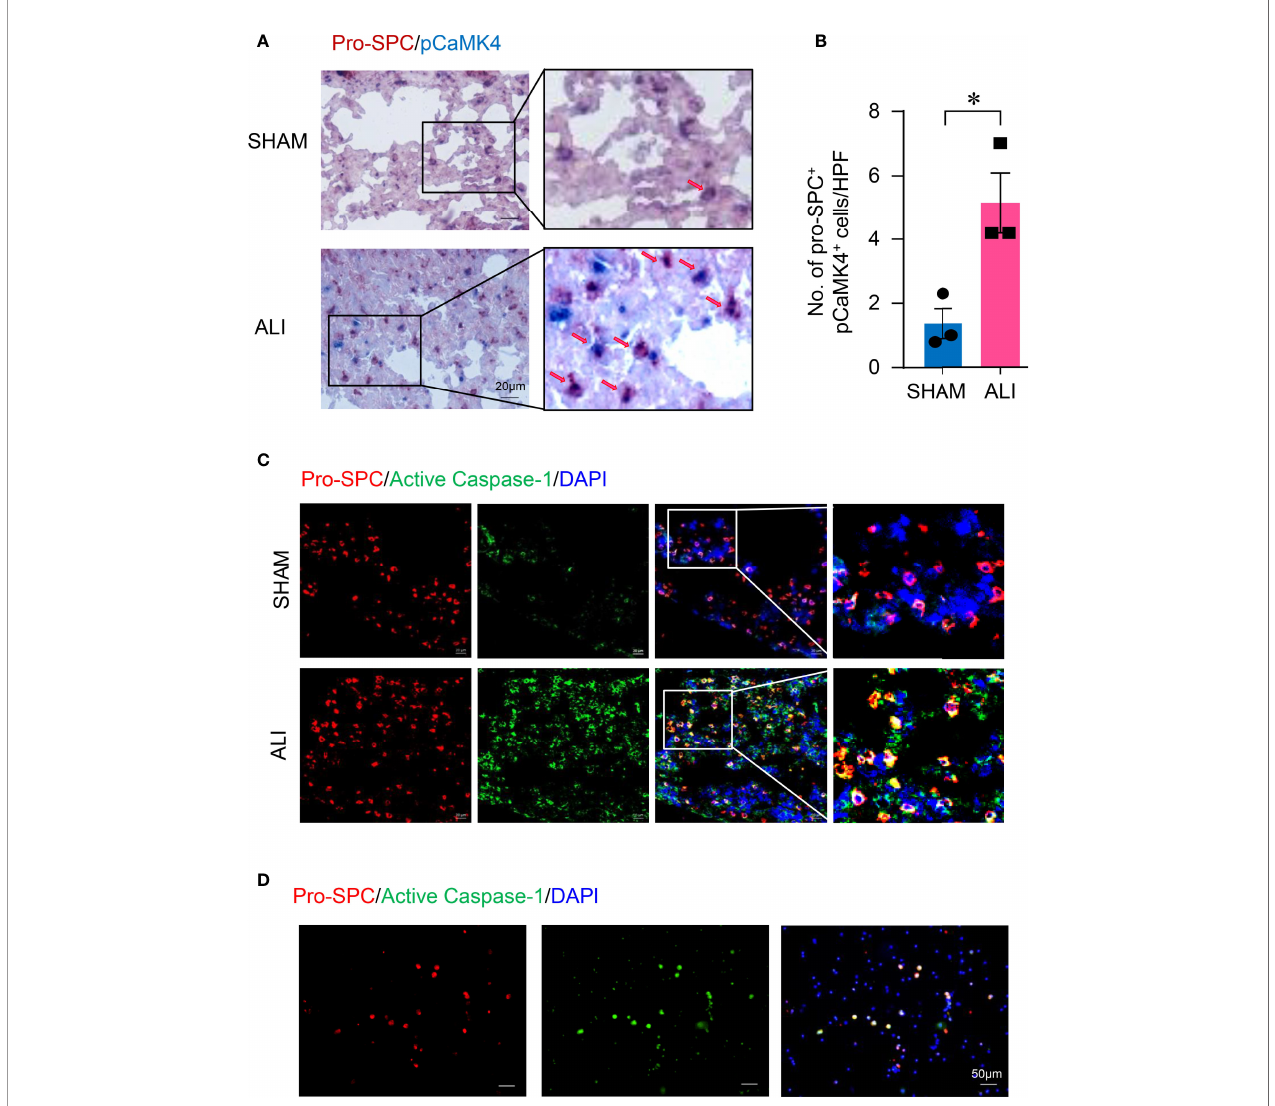
FIGURE 3 | Activation of CaMK4 and NLRP3 in fl ammasome in type II lung alveolar epithelial cells in ALI. (A, B) Lungs were collected from ALI or normal control mice and sectioned. pro-SPC (red) and pCaMK4 (blue) expression in the lung were identi fi ed by immunohistochemistry. Representative images were shown and numbers of pro-SPC + pCaMK4 + cells (arrows) in the lung tissues per high power fi eld (HPF) were summarized from 3 samples. Scale bar: 20 m m. (C) Slices from lungs of ALI or control mice were stained with Alexa Fluor A555-conjugated anti-pro-SPC (red) and FAM-FLICA (green). Representative images were shown. Scale bar: 20 m m. (D) Bronchoalveolar lavage fl uid (BALF) was collected from patients with ARDS and cells were isolated by centrifugation. Cells were stained with Alexa Fluor A555-conjugated pro-SPC (red) and FAM-FLICA (green). Representative images were shown. Scale bar: 50 m m. All data are mean± SEM. *p <